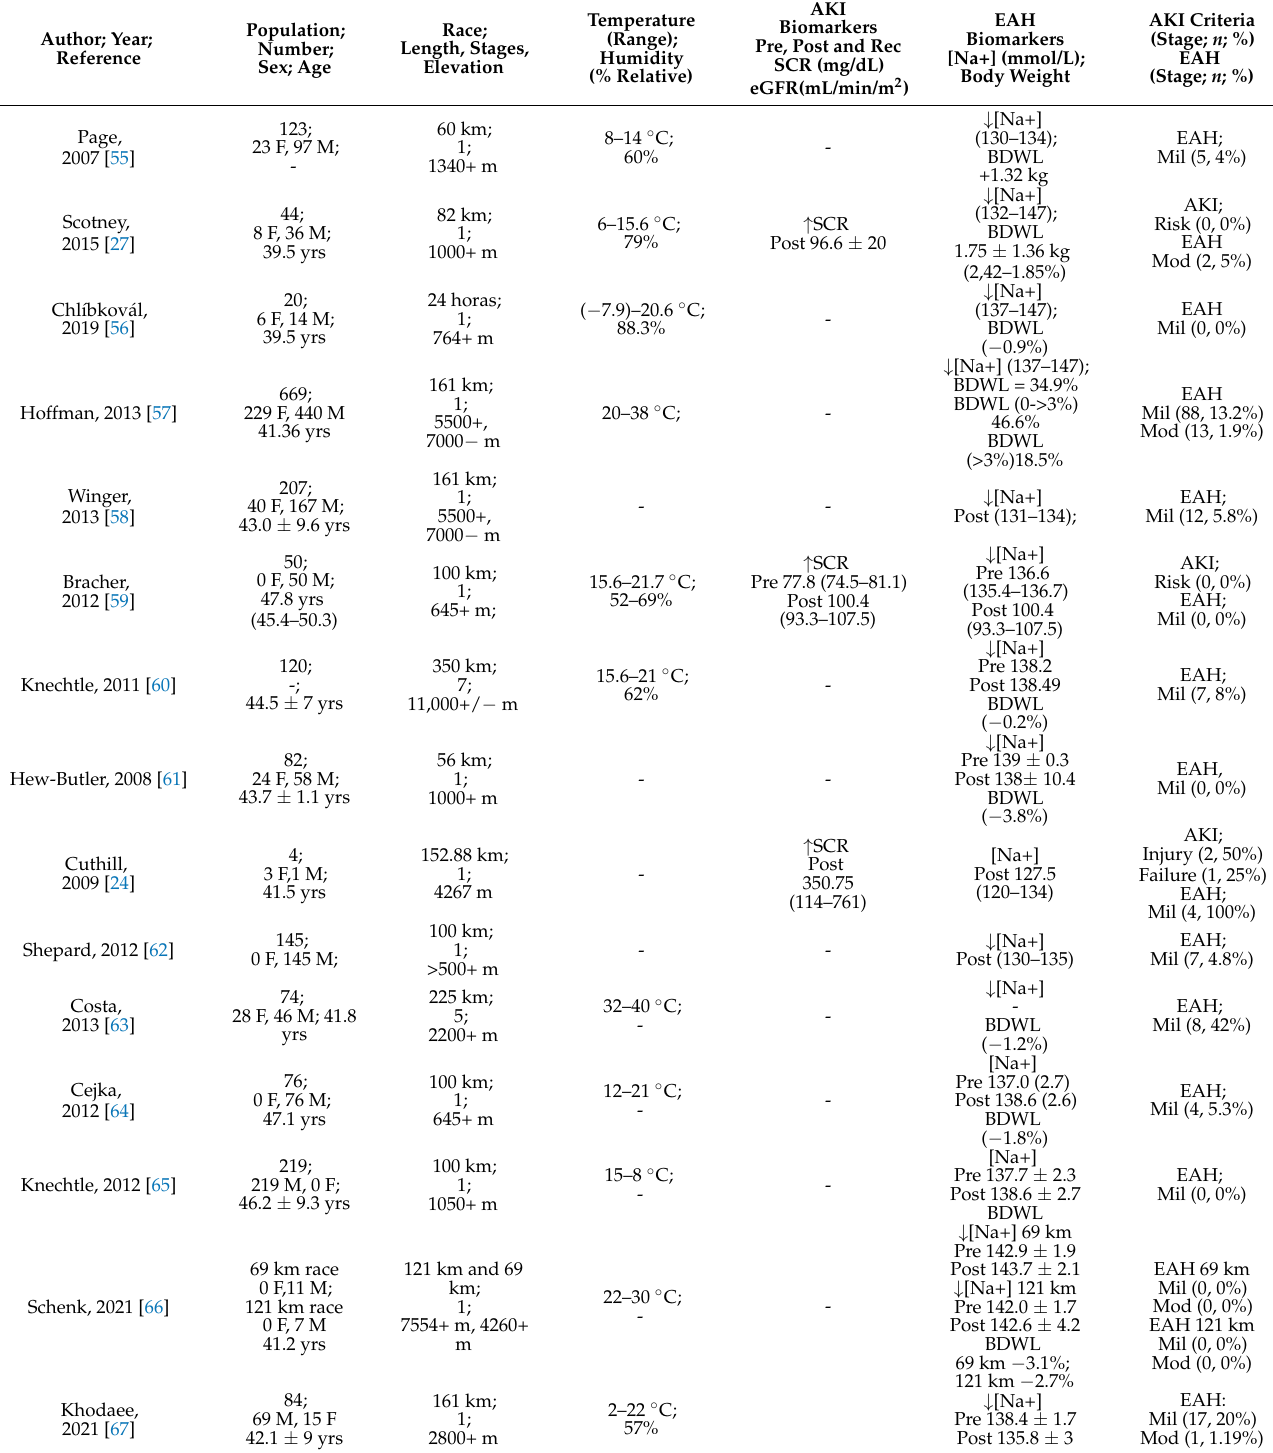
Table 2. Included studies examining EAH as the main target in subjects participating in ultra-trail